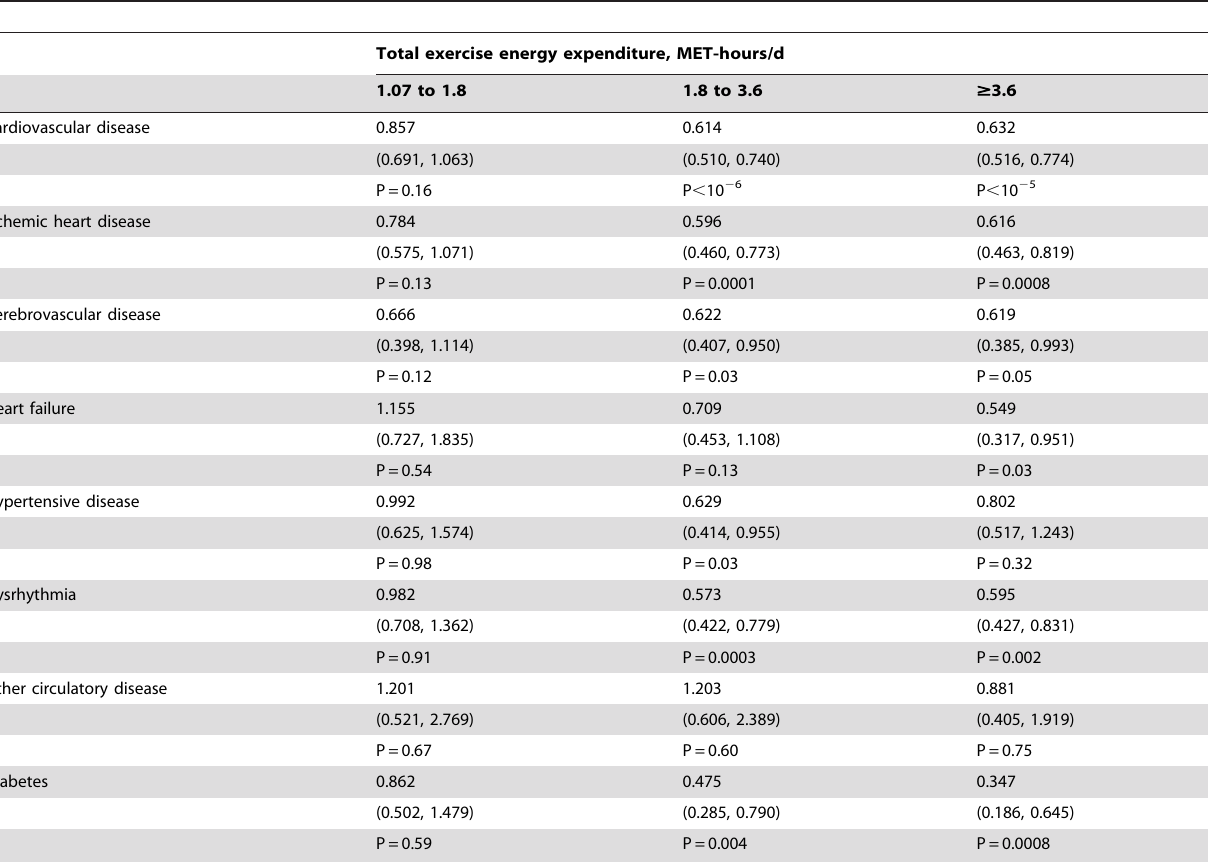
Table 8. Survival analyses of all related mortality, i.e., underlying or contributing causes of death, vs. categories of physical activity adjusted for medication use and BMI starting walking